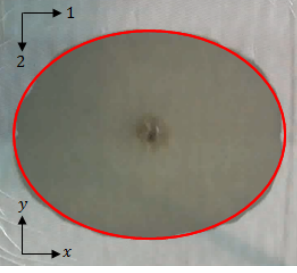
Figure 6: Resin front during 2D injection for 200 gsm woven